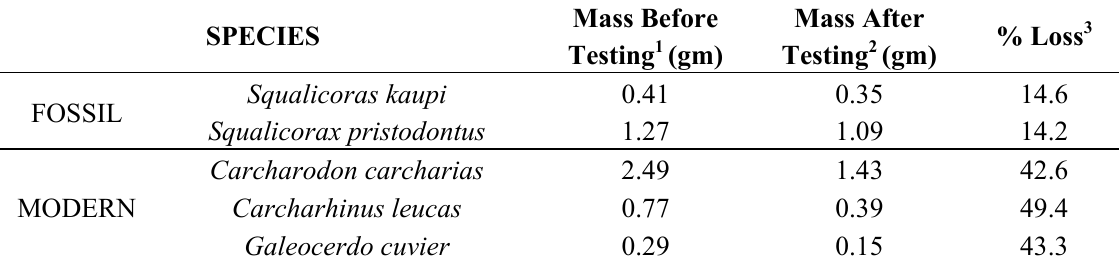
Table 2. Results of tumbling experiments conducted on functional teeth of S. kaupi , S . pristodontus , C. carcharodon , C. leucas and G . cuvier . The average mass of five teeth from each species was used before and after tumbling in calculating the percentage of lost mass.